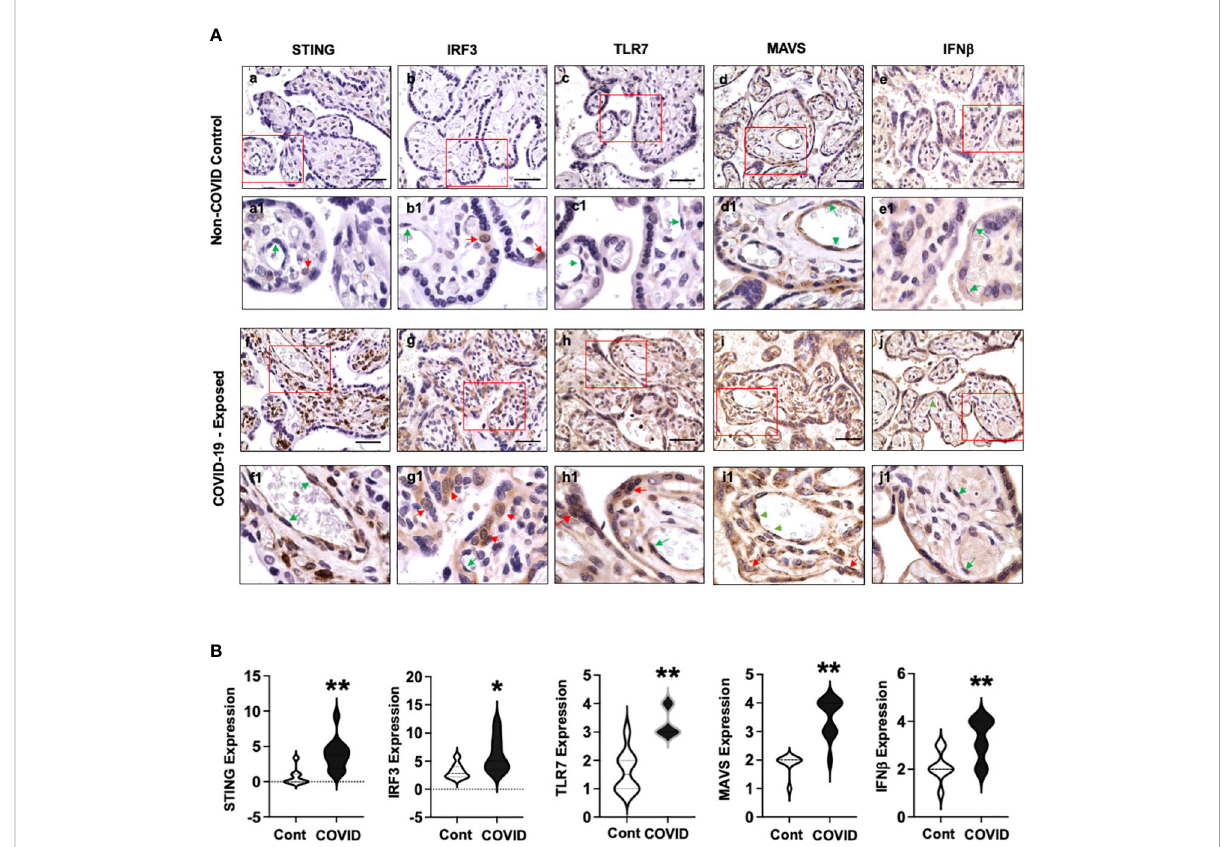
FIGURE 3 STING, IRF3, TLR7, MAVS, and IFN b expression in villous tissue of placentas with or without exposure to maternal COVID-19 infection. (A) STING, IRF3, TLR7, MAVS, and IFN b expression in villous tissues from placentas with or without exposure to maternal COVID-19 infection. Images a to e are representative images of STING, IRF3, TLR7, MAVS, and IFN b expression in villous tissue sections in non-COVID control placentas, and images a1 to e1 show zoom of enlarged rectangle area in a to e of each, respectively. Images f to j are representative images of STING, IRF3, TLR7, MAVS, and IFN b expression in villous tissue sections in COVID-exposed placentas, and images f1 to j1 show zoom of enlarged rectangle area in f to j of each, respectively. Bar = 50µm. Activation or upregulation of STING, IRF3, TLR7, MAVS, and IFN b expression were found in different cell-types in COVID-exposed placental villous tissue compared to non-COVID controls: 1) strong STING expression signal in stromal cells and fetal endothelial cells; 2) activation of IRF3 in CTs; and 3) increased TLR7 expression in STs, CTs, and fetal endothelial cells; 4) upregulation of MAVS expression in STs, CTs, stromal cells, and fetal endothelial cells; and 5) increased IFN b expression in STCs and fetal endothelial cells, respectively. Red arrow: CTs; Green arrow: fetal endothelial cells. (B) Violin graphs show that relative expression for STING, IRF3, TLR7, MAVS, and IFN b in villous tissue sections are signi fi cantly increased in COVID-exposed placental villous tissue (COVID) vs. non-COVID controls (Cont), * p<0.05 and ** p<0.01,